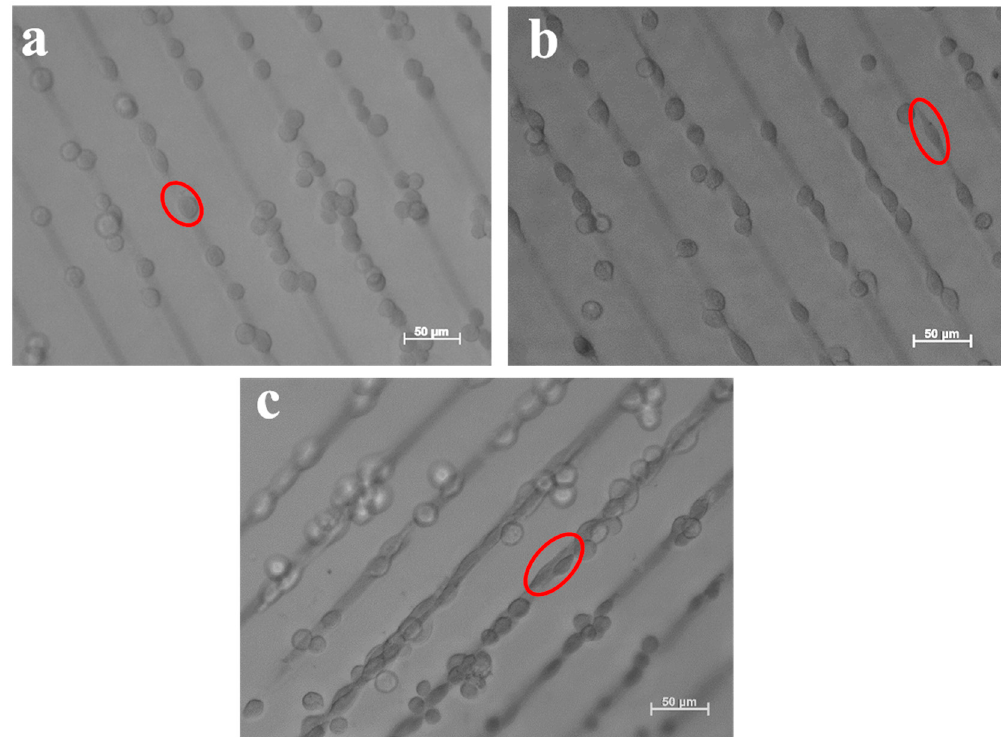
Figure 10 . Optical images of L-929 cells incubated with patterned Au NPs (d = 42 nm) on the surface of hydrogels (50 μ m in distance of the inter-stripes) for different incubation time: ( a ) 3 h; ( b ) 24 h and ( c ) 48 h, respectively. Red ellipses refer to L-929 cell growing on the patterned Au NPs stripes.